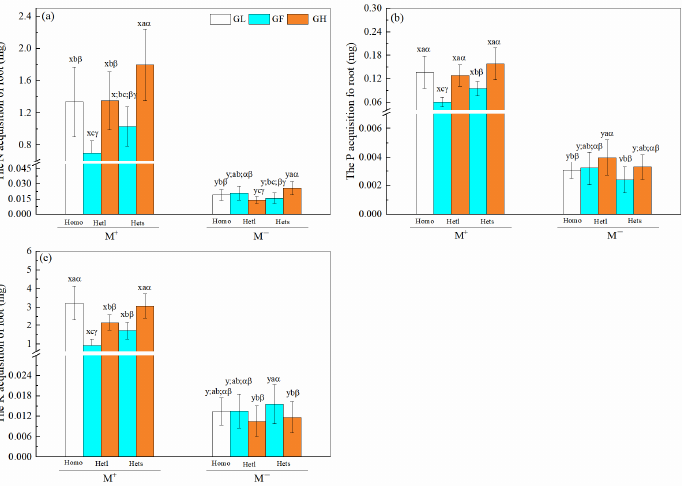
Figure 6. Acquisitions of N, P, and K through B. pilosa roots. ( a – c ) represent the nitrogen, phosphorus and potassium acquisition of plant roots, respectively. See Figure 2 for an explanation of M + , M − , Homo, Hetl, Hets, GL, GF, and GH, lowercase letters (x, y) and (a, b, c) and Greek alphabet ( α , β , γ ).